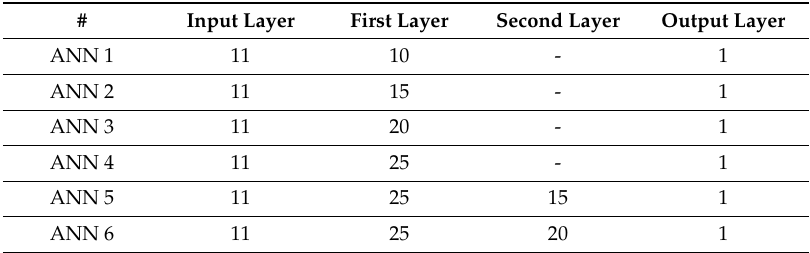
Table 2. Definition of NNs used.